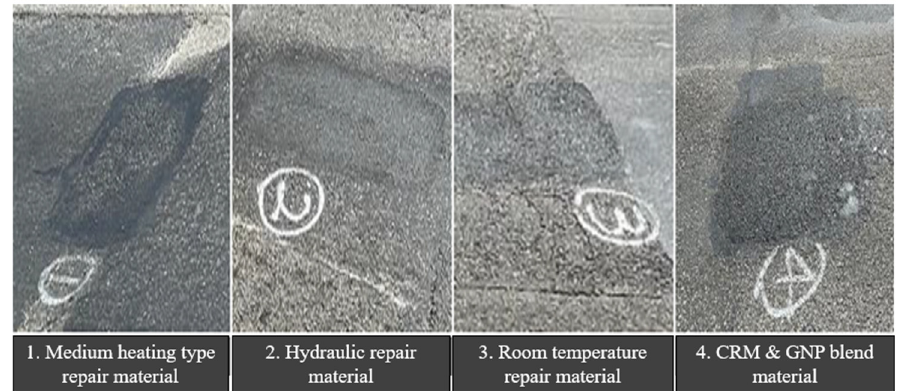
Figure 16. Result of visual inspection by compacting material after 10 days of construction.